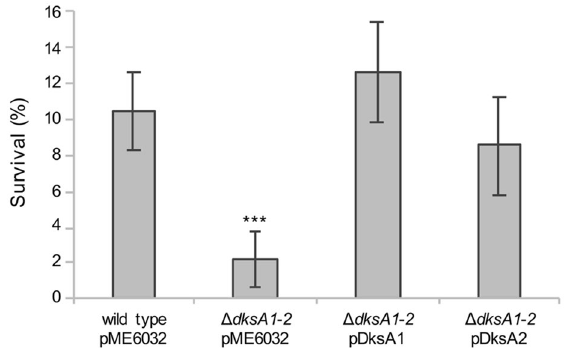
Figure 1. Effect of dksA paralogs on H 2 O 2 tolerance in P. aeruginosa planktonic cultures. Survival of the indicated strains grown in LB supplemented with 0.1 mM IPTG to the late exponential phase (OD 600 ≈ 2.5) after treatment with 50 mM H 2 O 2 for 30 min. Survival is expressed as percentage of the CFU counts of the treated samples relative to the CFU counts of the corresponding untreated controls. The average values from five independent experiments are reported with standard deviations. *** p < 0.001 versus wild type (ANOVA).